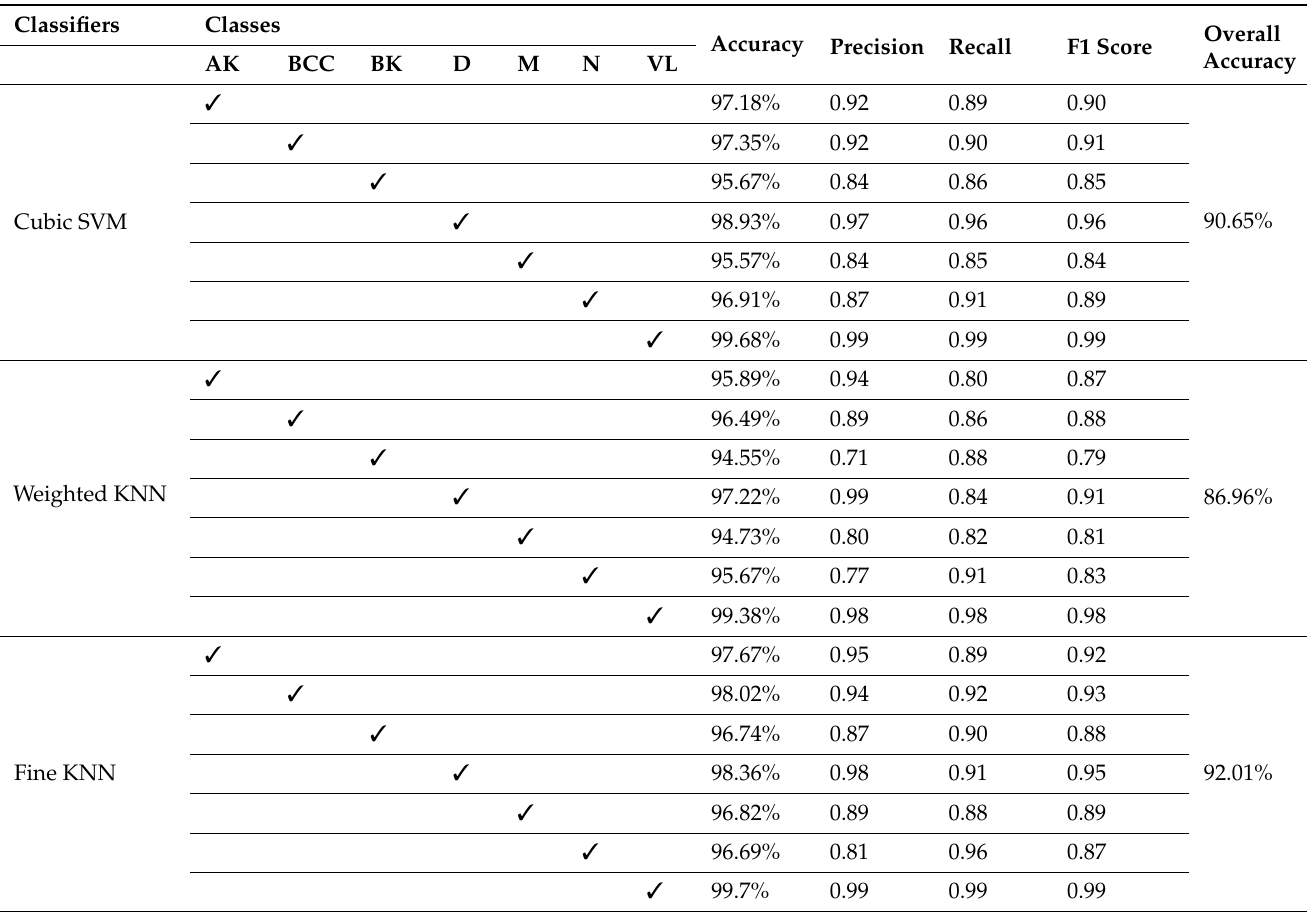
Table 10. Proposed classification model results on